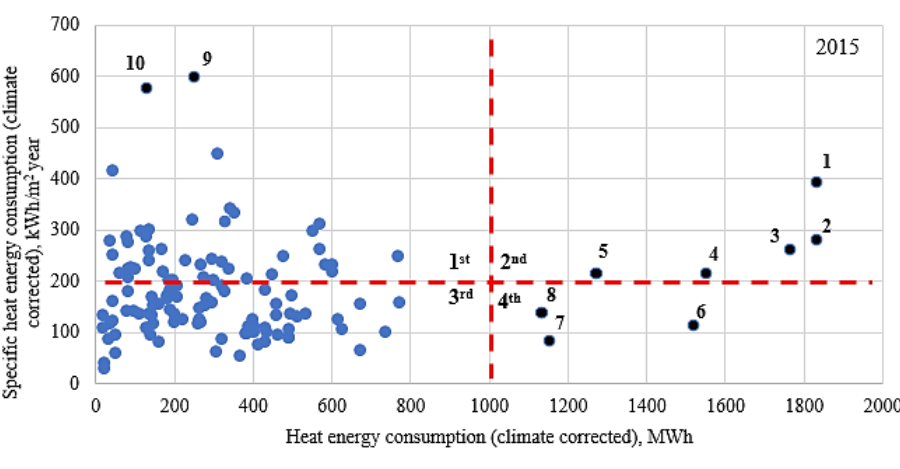
Fig. 6. Heat energy consumption at 123 municipal buildings of the city of Daugavpils in 2015.